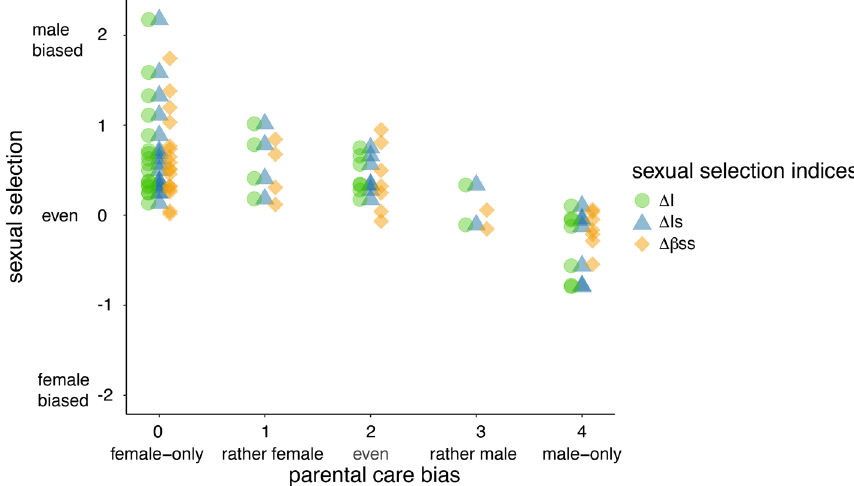
Figure 3. The intensity of sexual selection ( ΔI : opportunity of selection, ΔI s : opportunity for sexual selection, Δβ ss : Bateman gradient) in relation to sex-biased parental care (N = 37 species). Stronger sexual selection on males associates with female-biased parental care; the relationship is significant for all three indices of sexual selection (see Table 1). Shaded data points represent overlapping data. No imputed data were used in the figure. The figure was prepared using RStudio version 4.0.0 https:// www.R- proje ct.